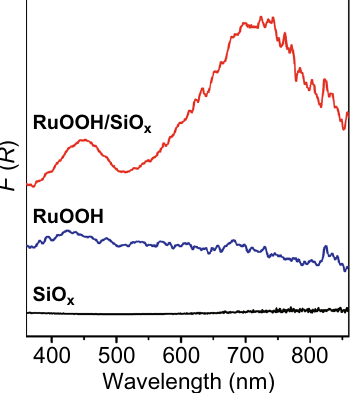
Fig. 2 DRS spectra of the synthesized RuOOH/SiO x composite par- ticles (red curve), RuOOH powder (blue curve), and SiO x NSs (black curve). (Color figure